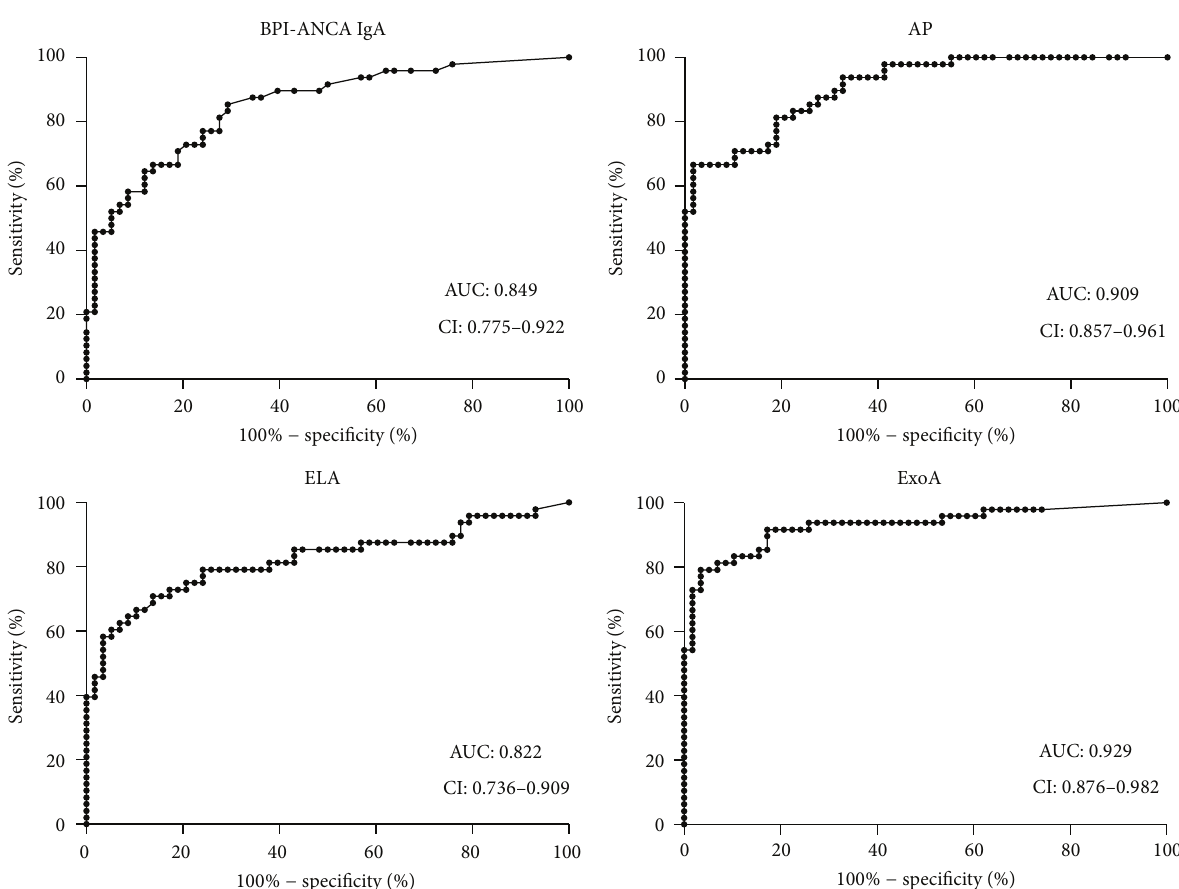
Figure 2: Identifying chronically colonized patients. ROC-curves of IgA BPI-ANCA and three different anti- P. aeruginosa serologies comparing their ability to identify patients with chronic P. aeruginosa colonization ( 𝑛 = 48 ). Controls were patients belonging to Leeds class 3 (free from earlier P. aeruginosa ) or 4 (never had P. aeruginosa ) ( 𝑛 = 58 ). Leeds 2 patients (intermittently colonized, 𝑛 = 11 ) were omitted in this analysis. All tests were useful for this purpose, Exotoxin A presenting the best area under curve with 0.929 (CI: